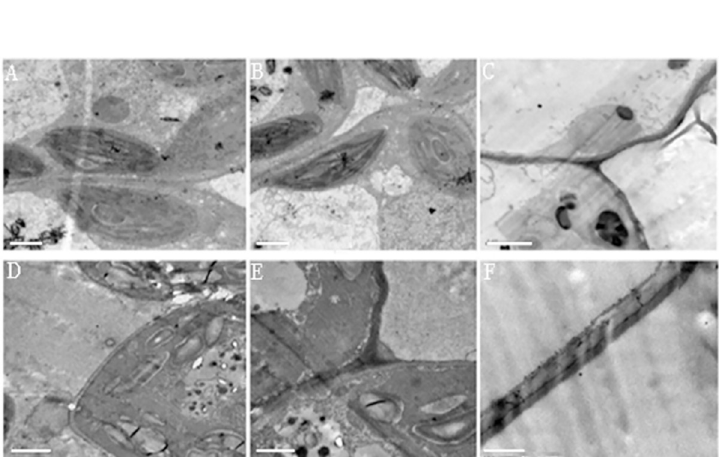
Fig 3. Transmission electron micrographs of chloroplasts and cell walls of green bracts and white bracts of S . chinensis . A, B) Chloroplast in green bract; D, E) Chloroplast in white bract; C) Cell wall in green bract; F) Cell wall in white bract; A and B, Scale bars represent 1 um; C, D, E and F, Scale bars represent 2 μ m.